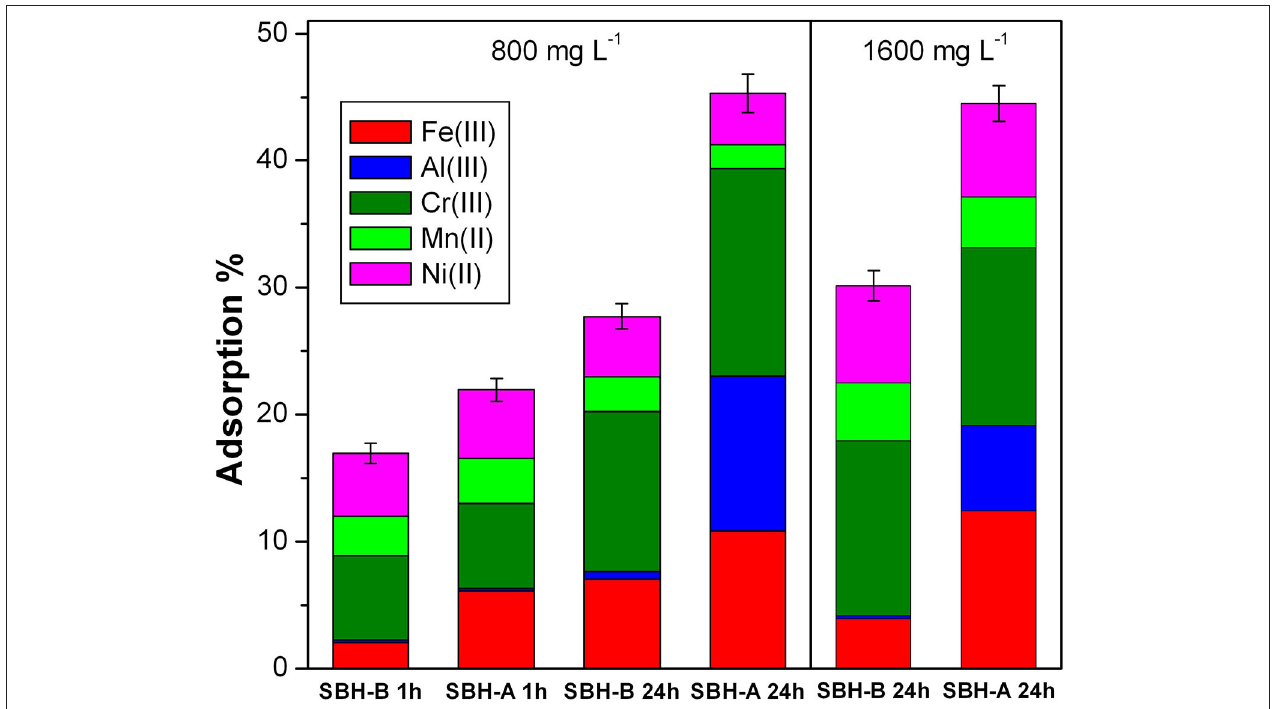
FIGURE 5 | Adsorption % of Fe(III), Al(III), Cr(III), Mn(II), and Ni(II) mixed together (1 × 10 − 5 M for each ion) at pH 5 in presence of SBH-B and SBH-A; Left panel conditions: hulls concentration 800mg L − 1 and contact times 1 or 24h; Right panel conditions: hulls concentrations 1,600mg L − 1 , contact time 24h. The adsorption % was calculated in relation to the total initial amount of metal ions in solution as described in the text.